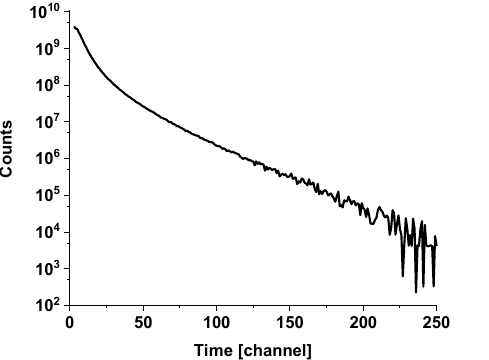
Fig. 6. Distribution of time intervals between successive pulses